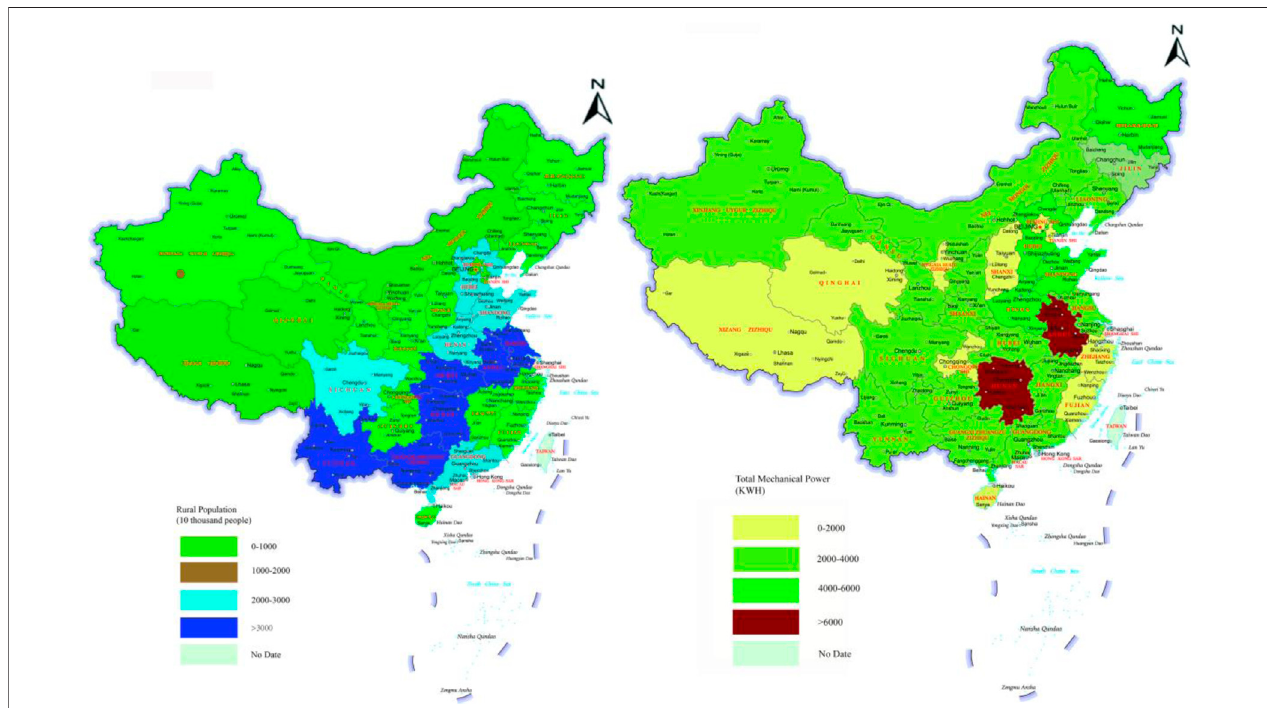
FIGURE 3 | Rural population and total mechanical power in 2019. ( A : Rural population; B : Total mechanical power).